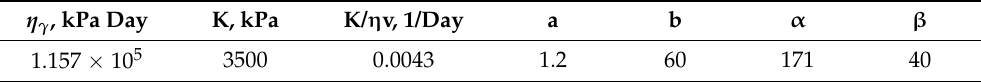
Table 1. Soil base